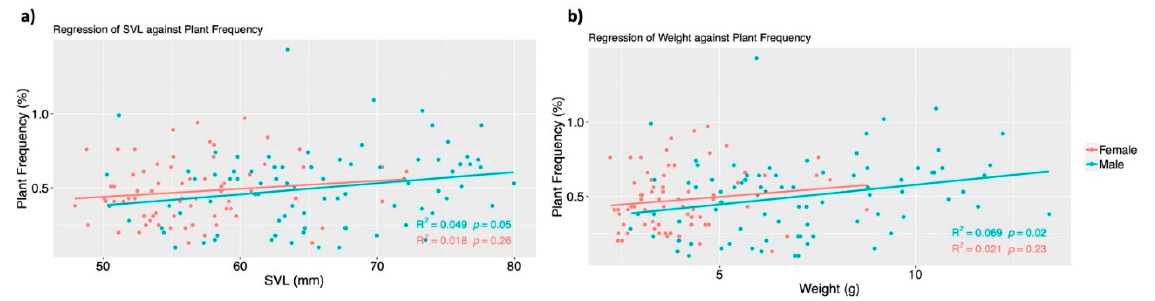
Figure 5. Linear regression of SVL ( a ) and weight ( b ) against plant frequency of occurrence in of both female and male adults of Teira dugesii . female and male adults of Teira dugesii